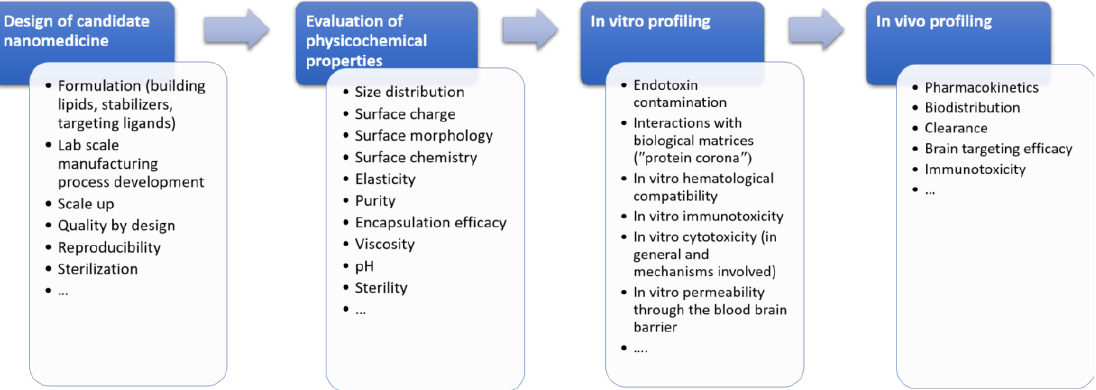
Figure 1. Key areas in the preclinical development of parenteral lipid-based nanoparticles specifically intended for neurological and other CNS disorders. The list is not exhaustive, as indicated by the last bullets with “ . . . ” following every list.